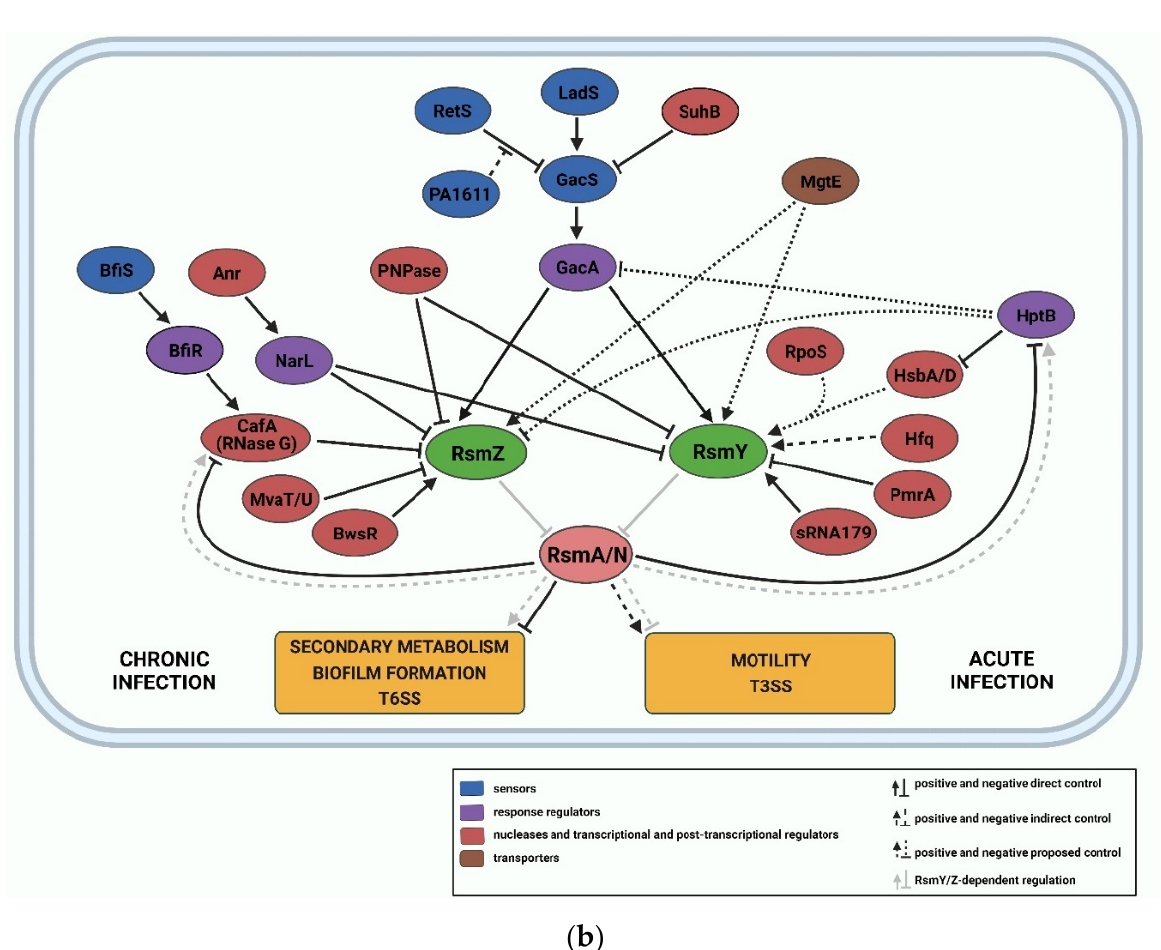
Figure 4. ( a ) The RsmA and RsmN/F regulons. RsmA and RsmN/F proteins can act as direct or indirect repressors or activators of different target mRNAs (in green) and pathways (in yellow), which contribute to the shift between the acute (planktonic) and the chronic (sessile, biofilm) lifestyle. RsmN/F protein synthesis is negatively controlled by RsmA at the translational level. The scheme was drawn based on previous reports [139,143,184]. ( b ) Synthesis and turnover of RsmY/Z RNAs. The RsmY and RsmZ RNAs serve as molecular decoys for the RsmA/N proteins, which in turn mediate the transition from an acute to the chronic infection phenotype ( a ). Transcription and turnover of RsmZ and RsmY are under the control of several two-component systems (sensors: blue ovals; response-regulators: violet ovals), transporters (brown ovals), nucleases and transcriptional and post-transcriptional regulators (dark red ovals), which act either in a GacA/S-dependent (e.g., SuhB-mediated repression of RsmY/Z synthesis) or independent manner (e.g., Anr-mediated repression of RsmY/Z expression). Some regulators affect the abundance of both RNAs (e.g., GacA/S transcriptional activation of RsmY/Z), whereas some are specific for only one of the RNAs (e.g., BfiR-dependent CafA degradation of RsmZ and Hfq-dependent stabilization of RsmY). The complex regulation of Rsm RNAs enables fine-tuning of the expression of RsmA/N targets in response to different environmental cues. Dashed lines: indirect control; dotted lines: proposed mechanism. Light grey lines indicate RsmY/Z-dependent regulation. Figure adapted from [188]. ↓ : positive control; ⊥ : negative con- trol.